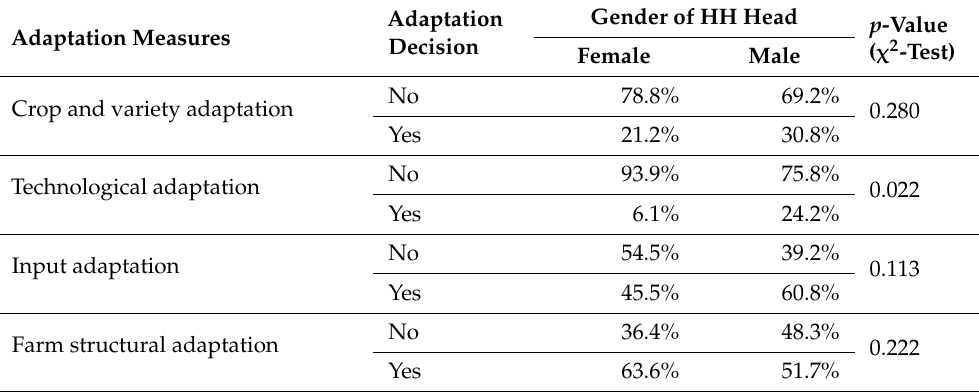
Table 8. Gender and climate change adaptation measures in the study area.